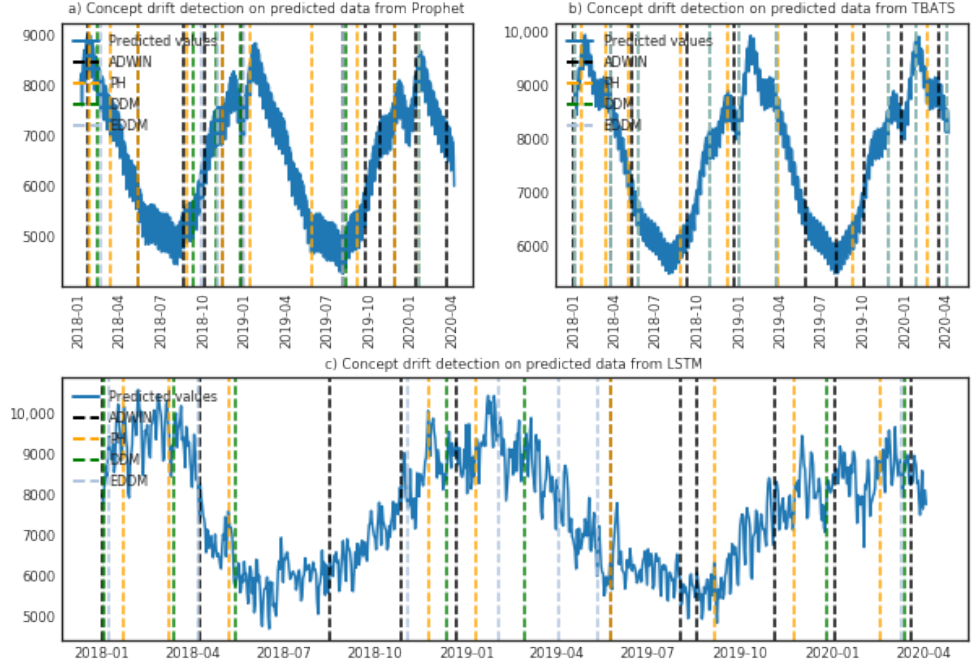
Figure 8. Concept drift detection for Fingrid [74] , X axis shows DateTime and Y axis the value